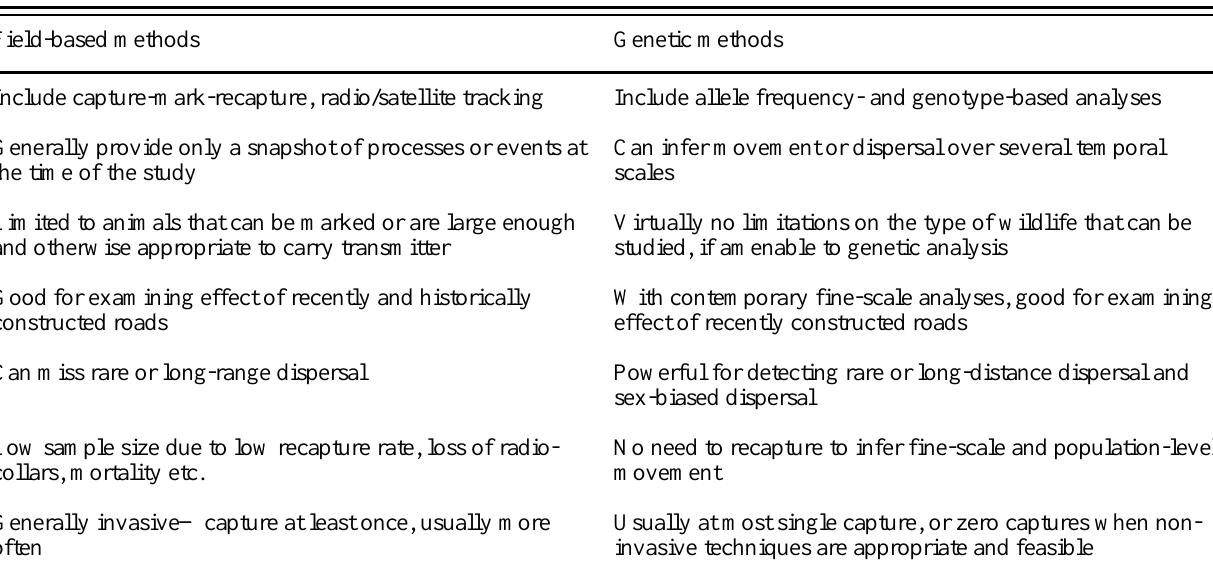
Table 1. Summary of the main characteristics of field-based and genetic methods. Field-based methods Genetic